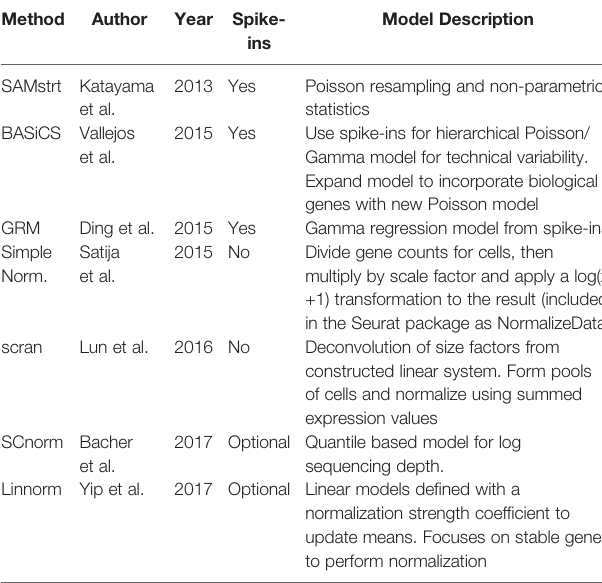
TABLE 2 | Summary of normalization methods, including the basic description and whether the method uses spike-in genes